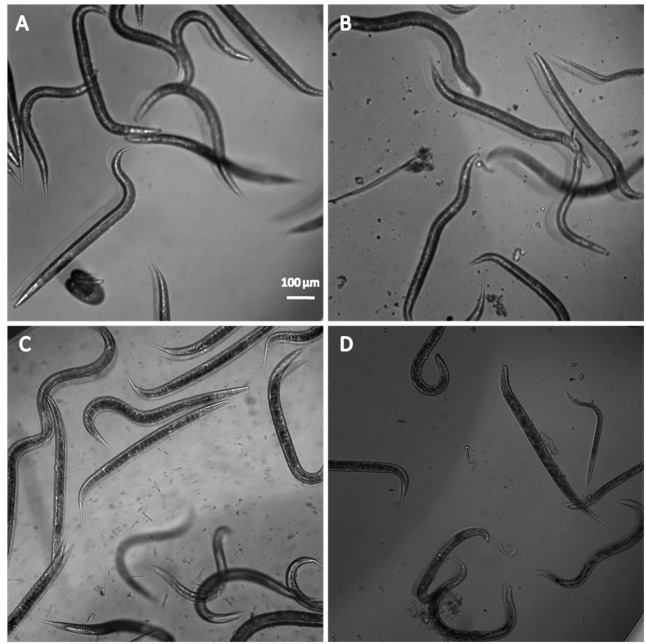
Representative image of C. elegans N2 (A) untreated, treated with (B) NLS, (C) dodecyl protocatechuate, and (D) and NLS+dodecyl.